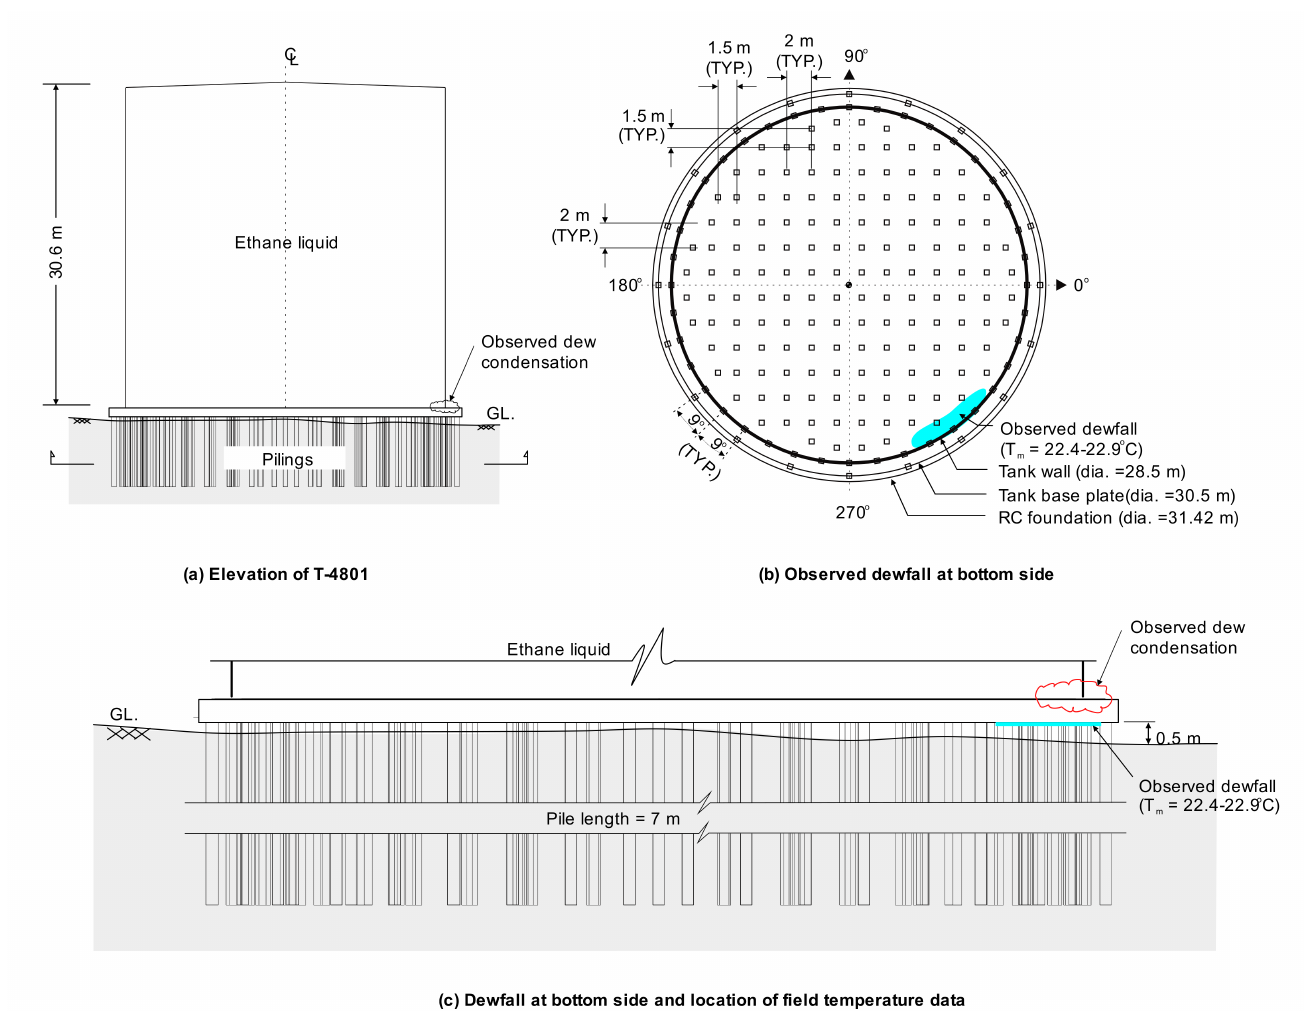
Figure 2. ( a ) Elevation of T-4801 tank, ( b ) plan view of foundation and location dew at the outer shell wall plate and bottom plate, and ( c ) lateral view of foundation and location of dew